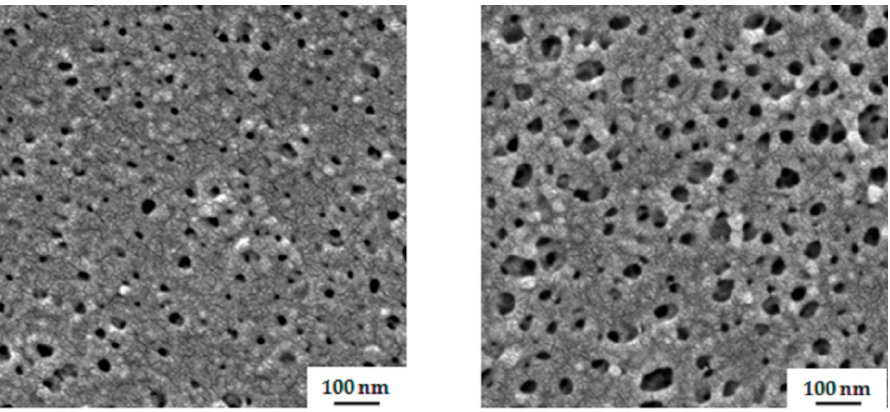
Figure 5. SEM images of the top surface of cast membranes from 24 wt % PS 76 -PSMA 24200 from ( left ) THF/DMF 50/50 wt %, ( right ) THF/DMF 40/60 wt %. The time of evaporation before immersion into precipitant was 10 s.